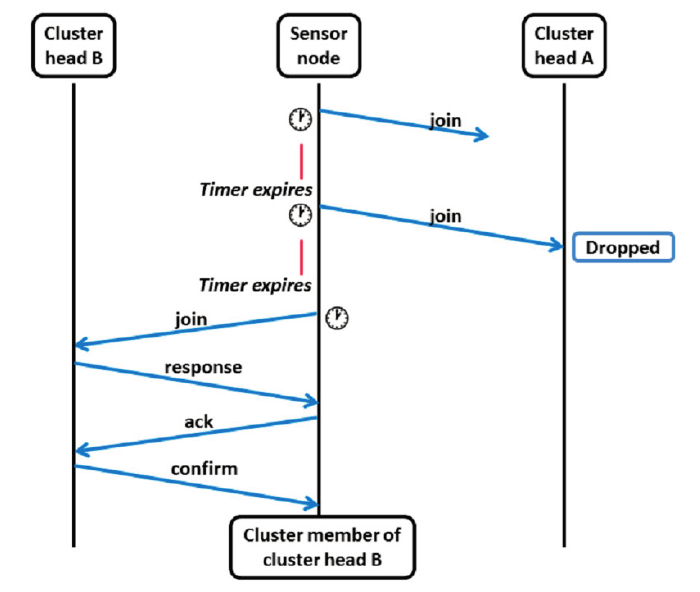
Figure 5. Procedure for registration to a cluster